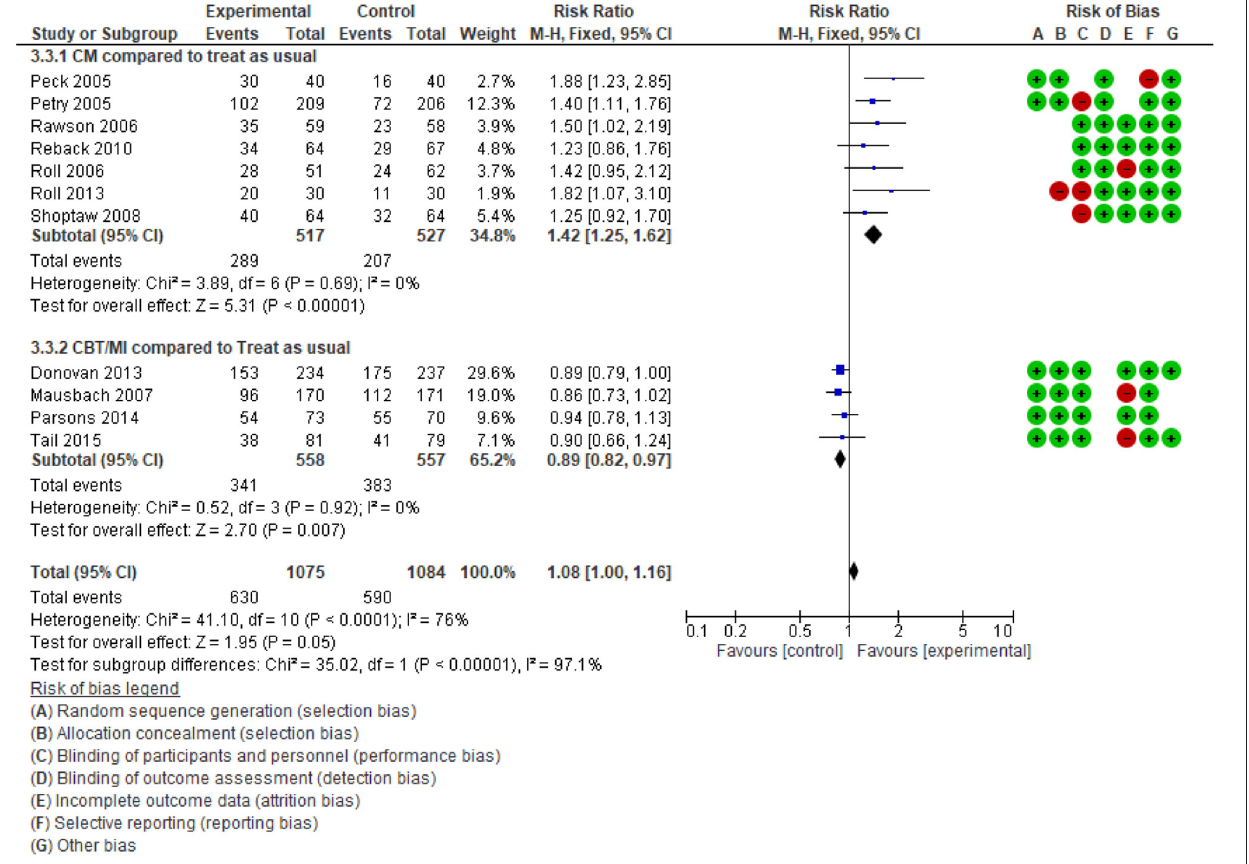
FIGURE 5 | Comparison percentage of follow up treatment until the